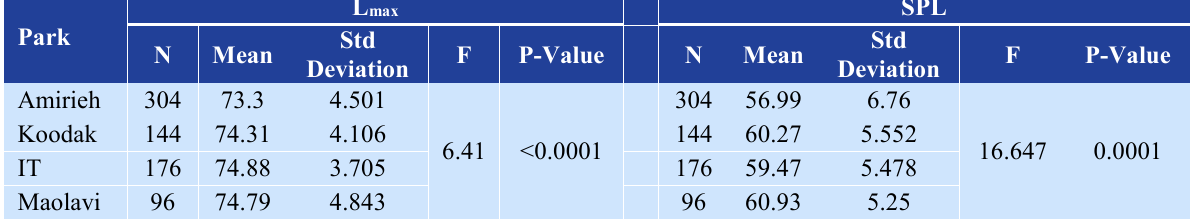
Table 2. Statistical mean of the measured L max and SPL in the